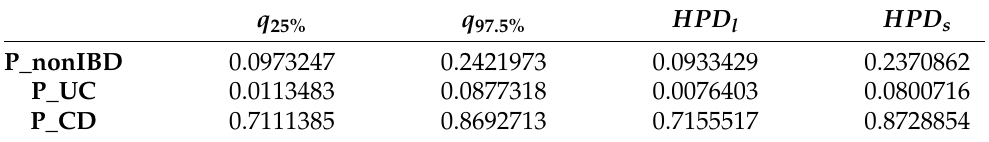
Table A3. 95% credible intervals: A_CD .